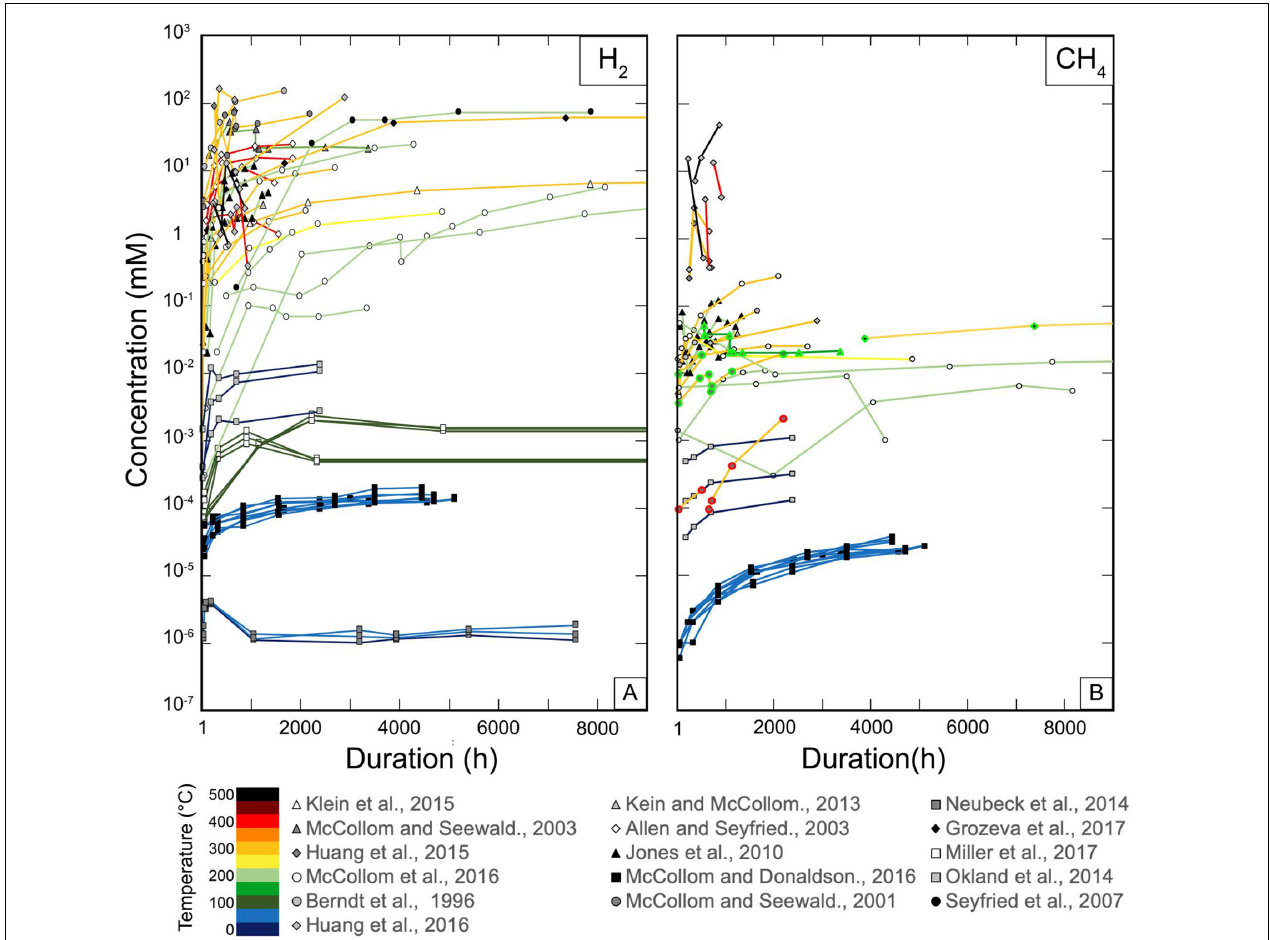
FIGURE 2 | Summary of H 2 (A) and CH 4 (B) concentrations produced as a function of time and temperature during serpentinization experiments, in which duration can reach ca. 11 months. Concentrations span over eight orders of magnitude from nanomoles to hundreds of millimoles.